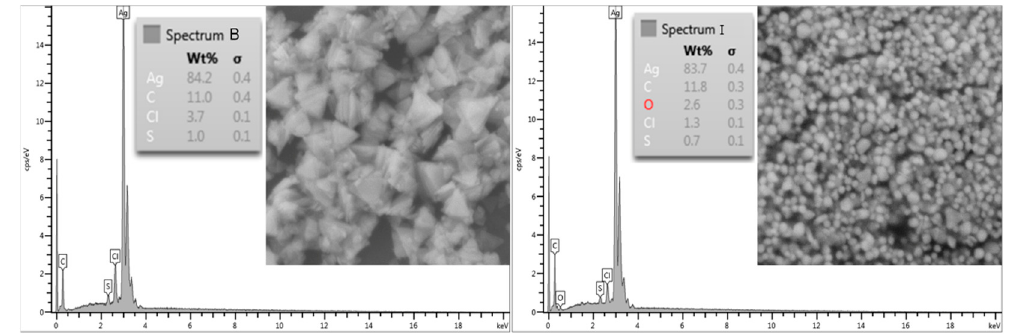
Figure 5. The energy-dispersive X -ray spectroscopy of both samples B and I.